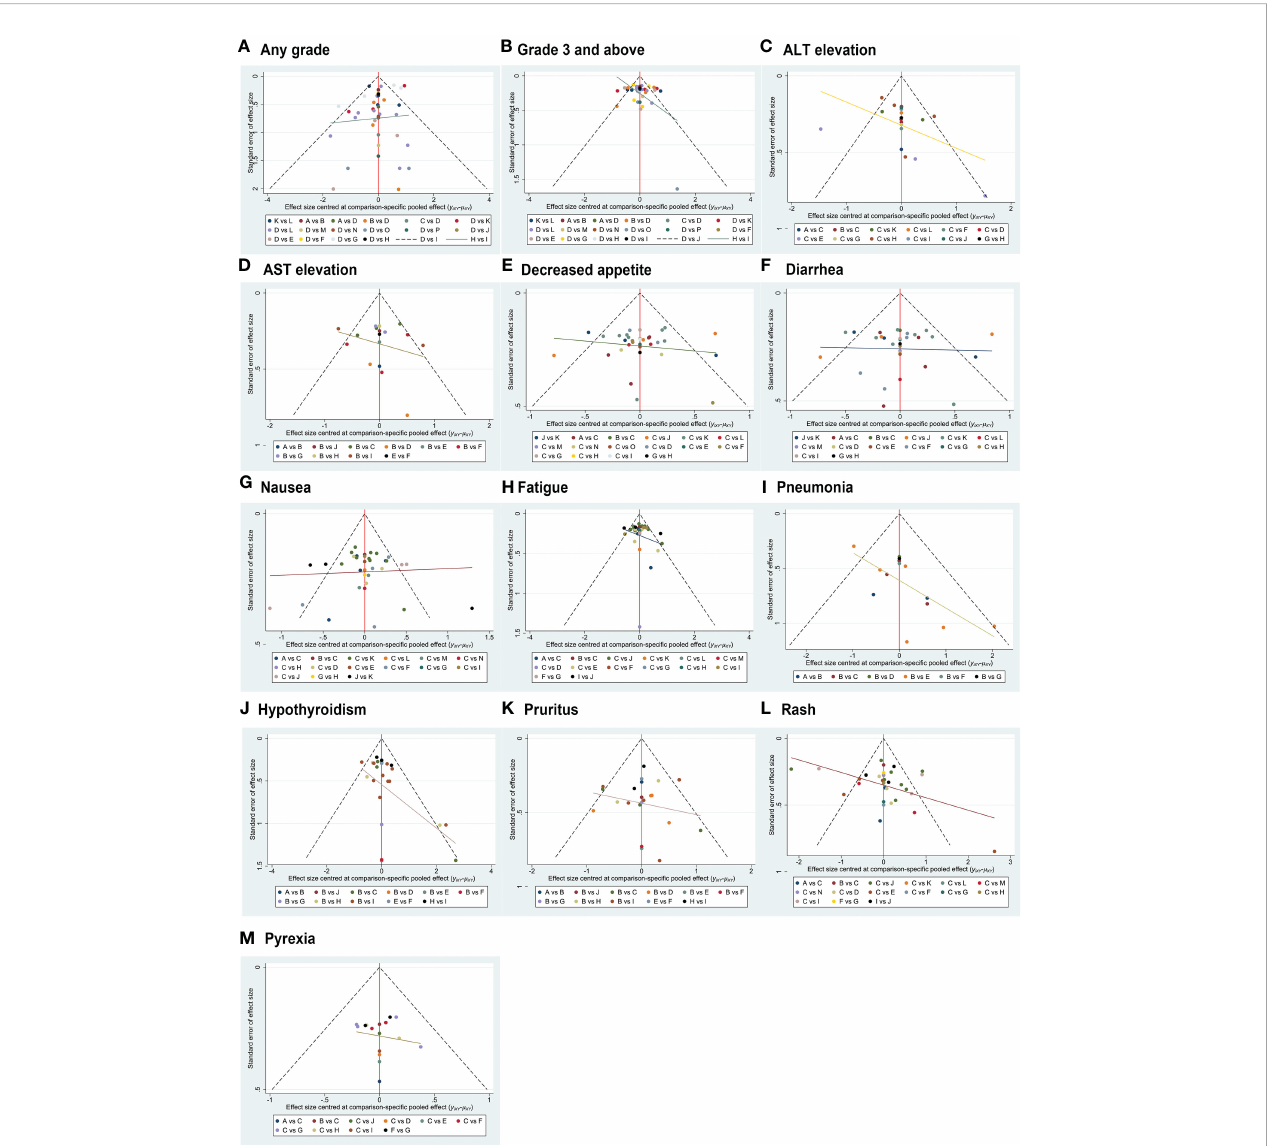
FIGURE 6 Funnel plot-based evaluation of publication bias. The symmetrical funnel plot distribution suggests a lack of publication